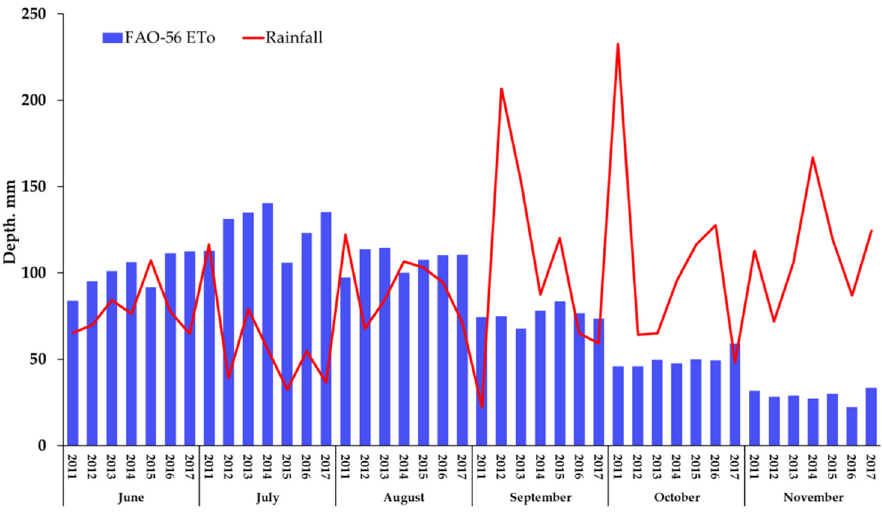
Figure 6. A comparison of rainfall and FAO-56 ETo for the study period 2011–2017.